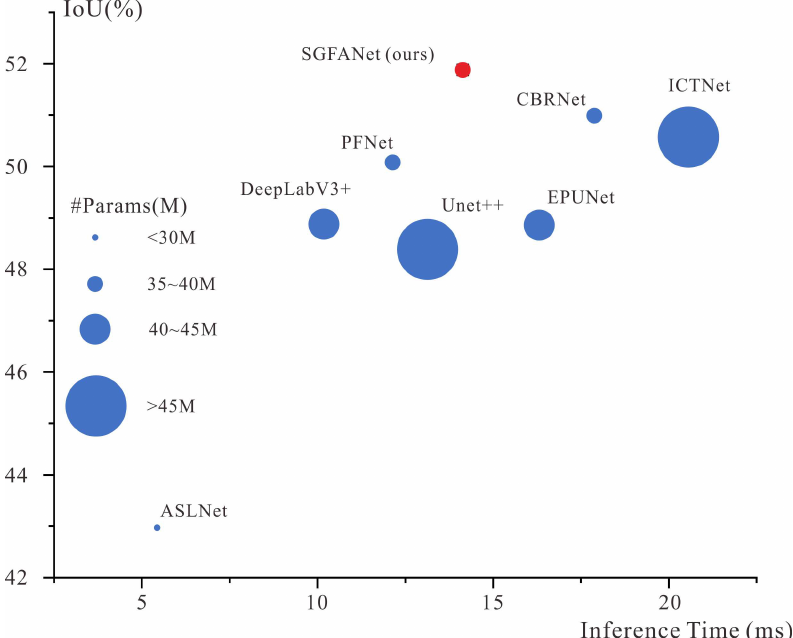
Figure 14. Speed versus accuracy on the DREAM-A+ dataset. The radii of circles represent the number of parameters (million). All the methods were tested with one V-100 GPU for a fair